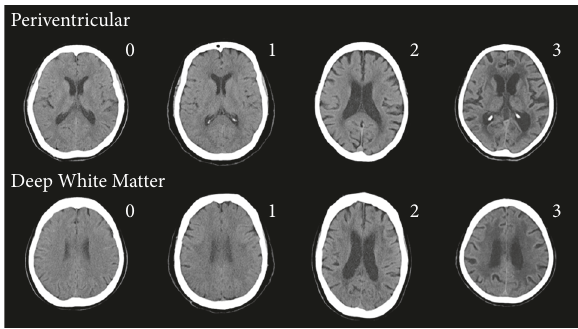
Figure 9: WMC in AD patients with Fazekas scale